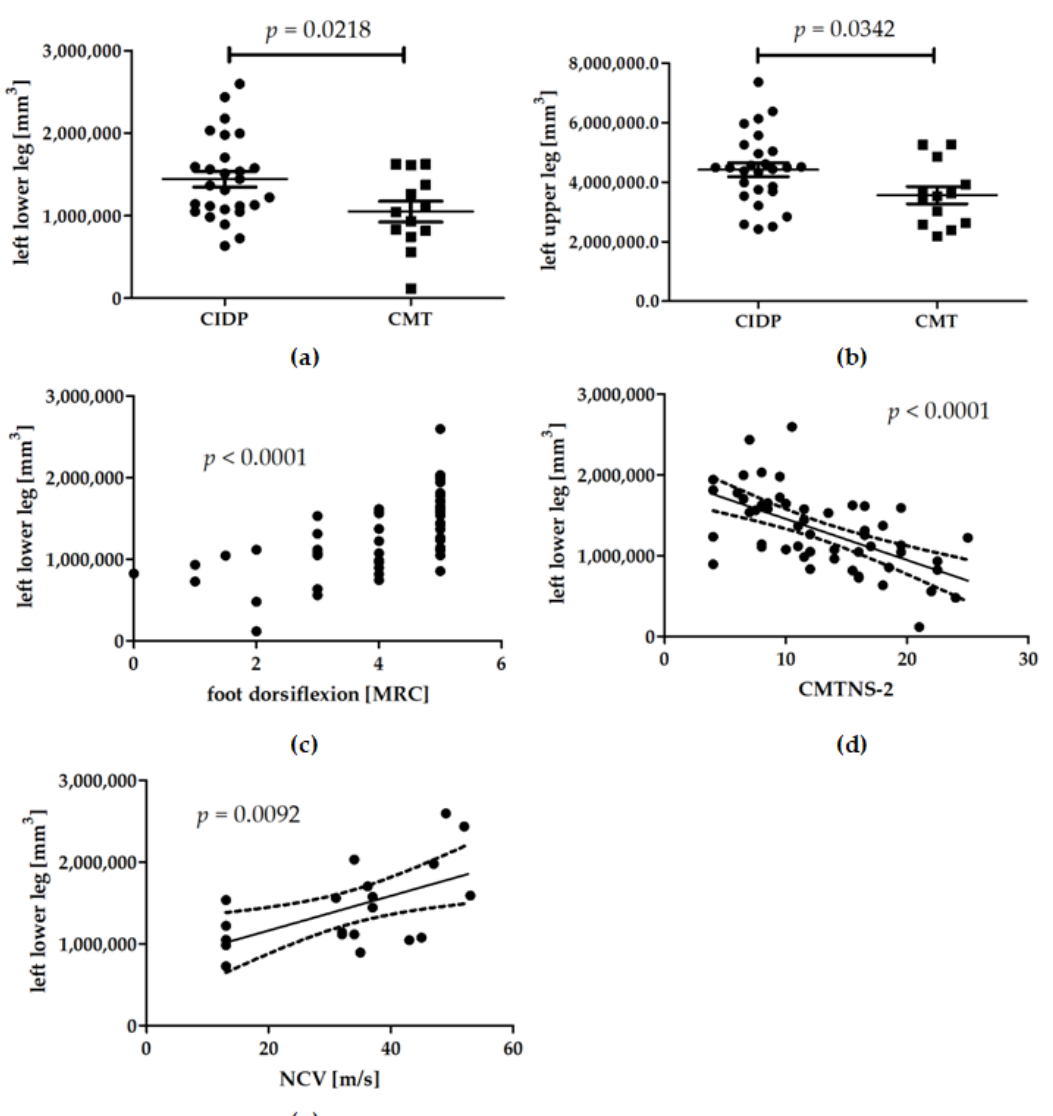
Figure 2. ( a – e ) . MRI-based muscle volumetric data as a function of disease entity ( a , b ) and clinical as well as neurophysiological reference measures ( c – e ).( a , b ) Comparison of left leg muscle volumes in CIDP (chronic inflammatory demyelinating polyneuropathy) vs. demyelinating CMT (Charcot-Marie-Tooth) patients: CIDP patients showed significantly higher muscles volumes in lower (( a ), p = 0.0218) and upper (( b ), p = 0.0342) legs than CMT patients.( c ) Linear regression of left lower leg muscle volumes and foot dorsiflexion strength (range from zero to five according to the Medical Research Council (MRC))( p < 0.0001).( d )Linear regression of left lower leg muscle volumes and Charcot-Marie-Tooth neuropathy score version 2 (CMTNS-2)( p < 0.0001). ( e )Linear regression of the left lower leg muscle volumes, and CIDP patients’ nerve conduction velocity (NCV) of thetibial nerve ( p = 0.0092). In four patients, the NCV was too slow to be detectable due to massively damaged nerves, and was therefore set one value below the lowest detectable NCV value.